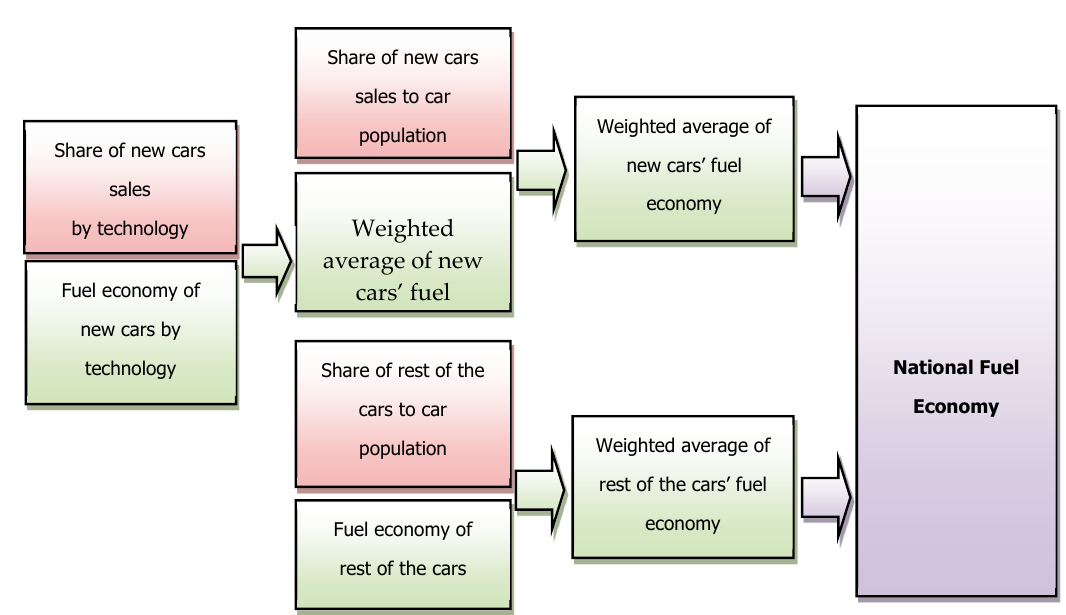
Figure 5. Aggregation of fuel economy between new and other cars.